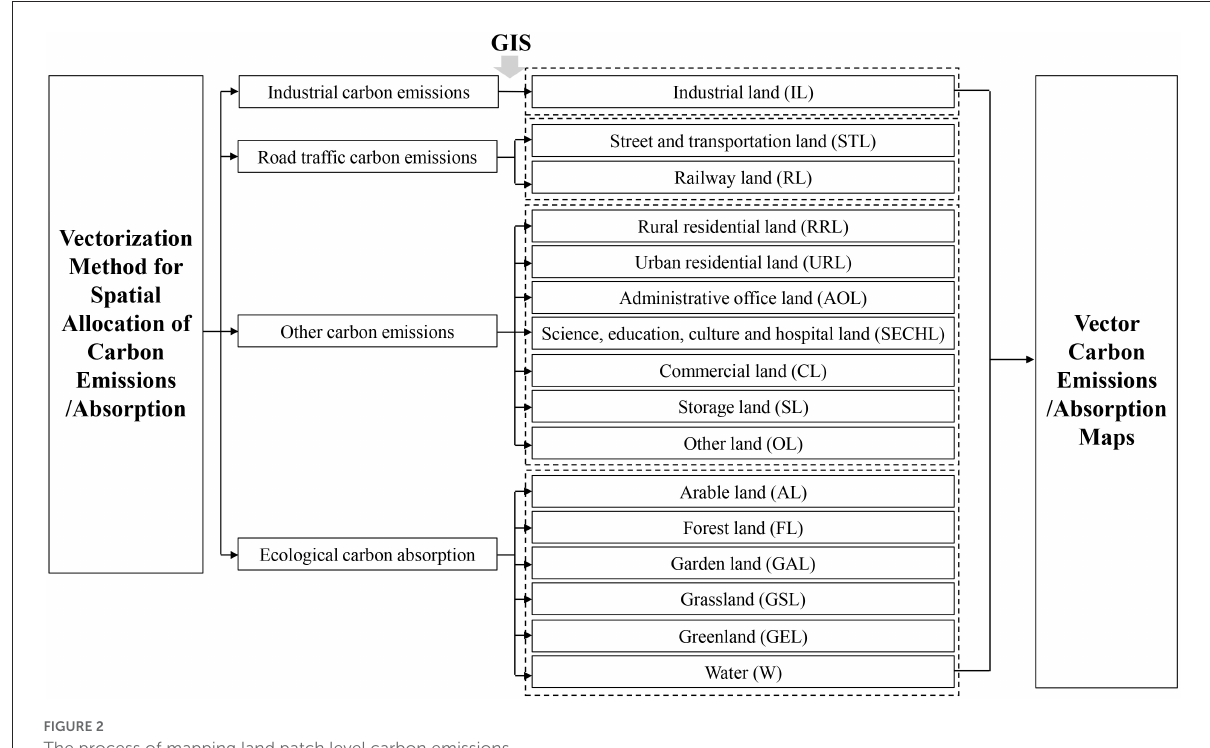
FIGURE2 The process of mapping land patch level carbon emissions.